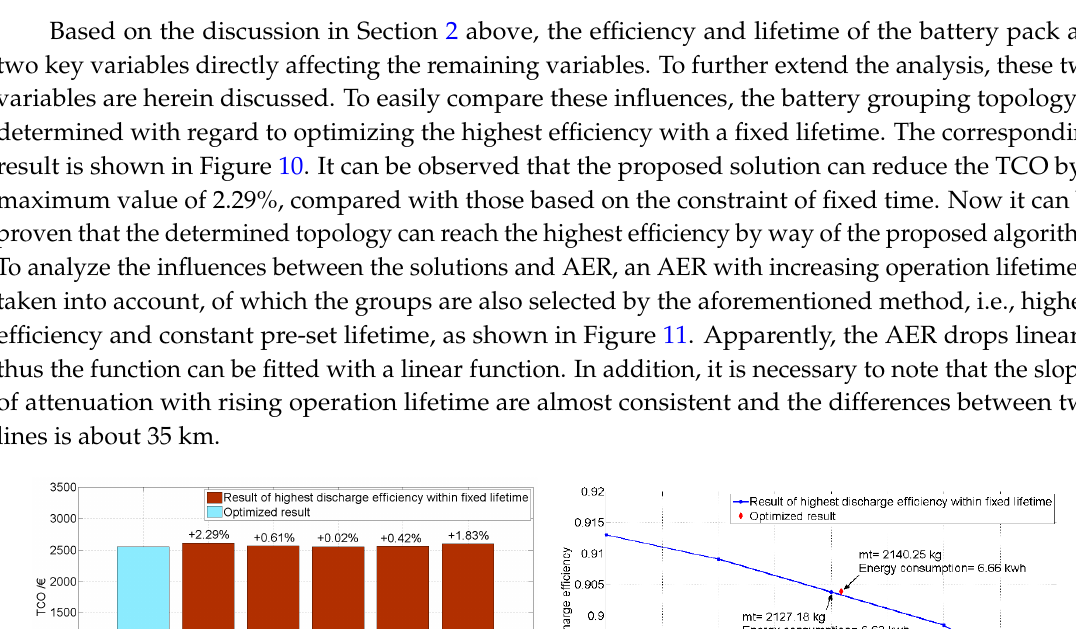
Figure 9. The results comparison.